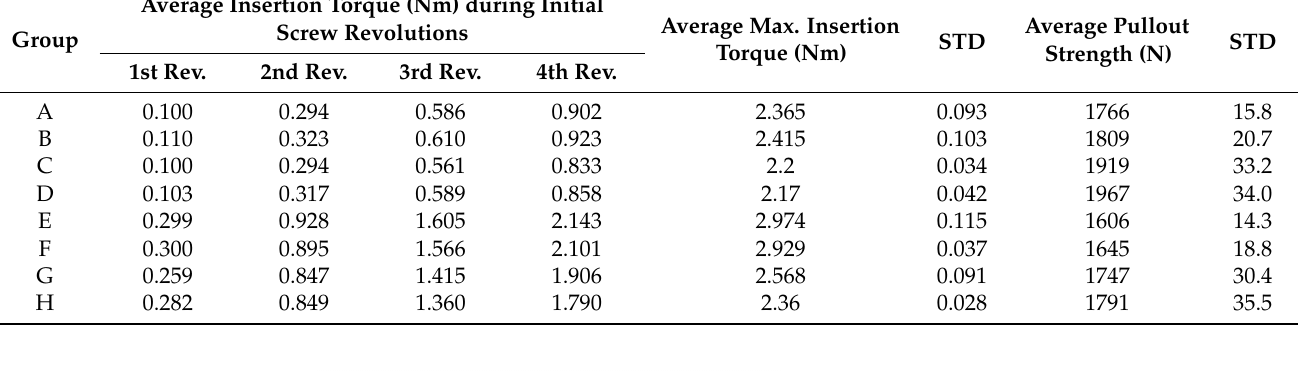
Figure 4. Plot of screw insertion torque and displacement for Groups D and H.